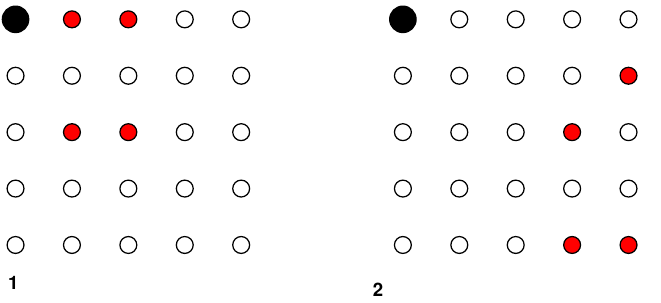
Figure 4. Examples of initial location of data for network of 25 nodes. The case marked “1” may be solved significantly faster than “2”. Nodes having data to send are marked in red, base station is in the larger black